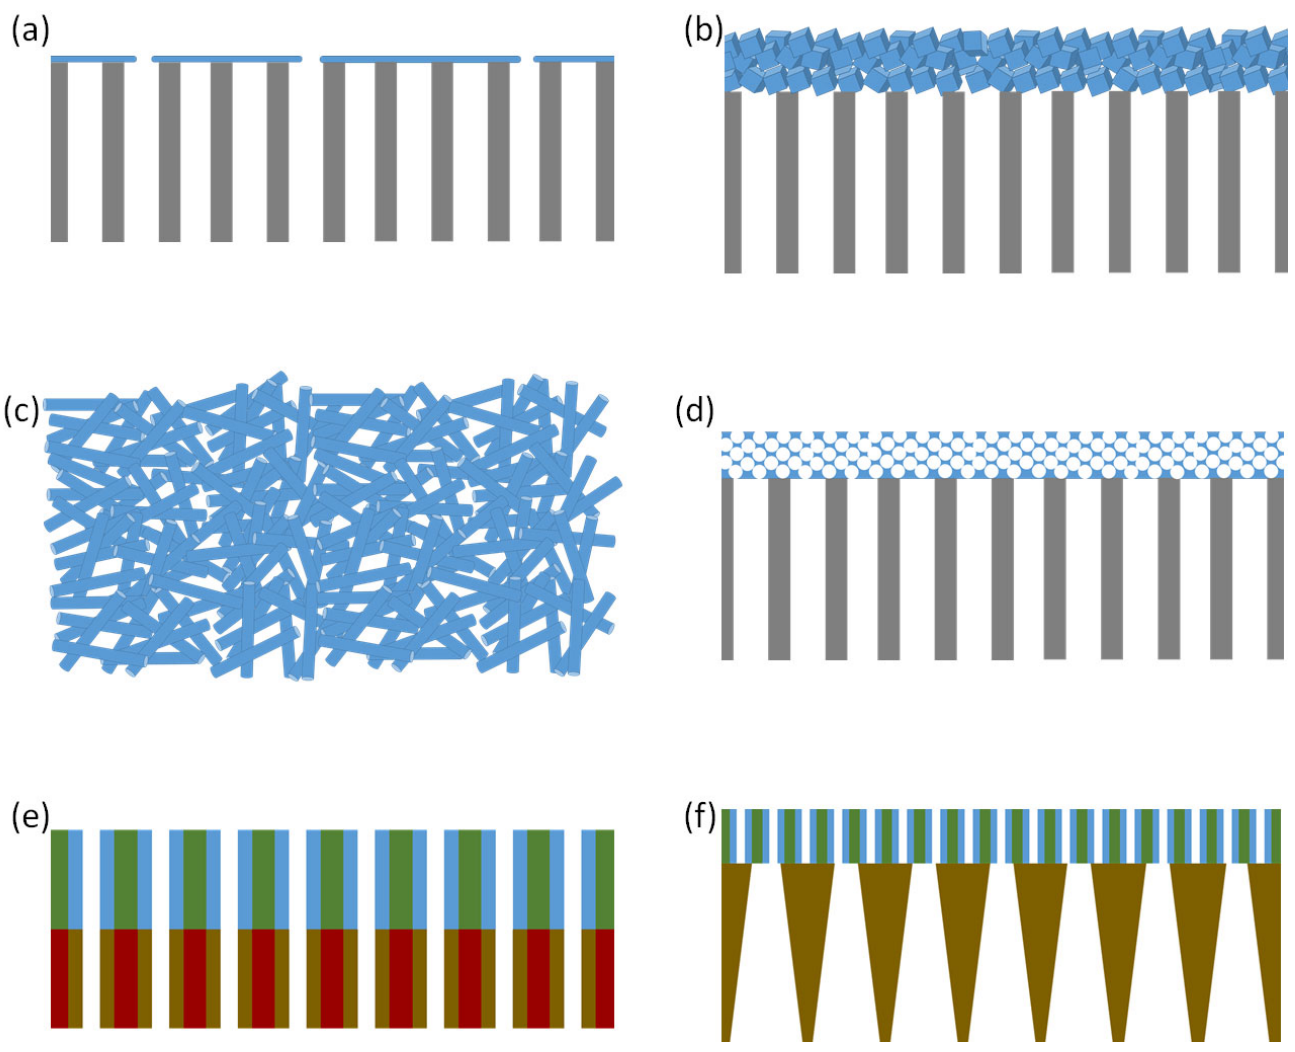
Figure 5. Schematic representation of membranes with ( a ) an ultrathin porous layer with atomic ‐ or molecular ‐ scale thickness on a porous support, ( b ) a metal organic framework layer on a porous support. ( c ) randomly assembled nanofibers with 3D interconnected pores, ( d ) a mesoporous carbon or silica layer on porous support, ( e ) two porous block copolymer layers, ( f ) a porous block copoly ‐ mer layer on top of a track ‐ etched layer.